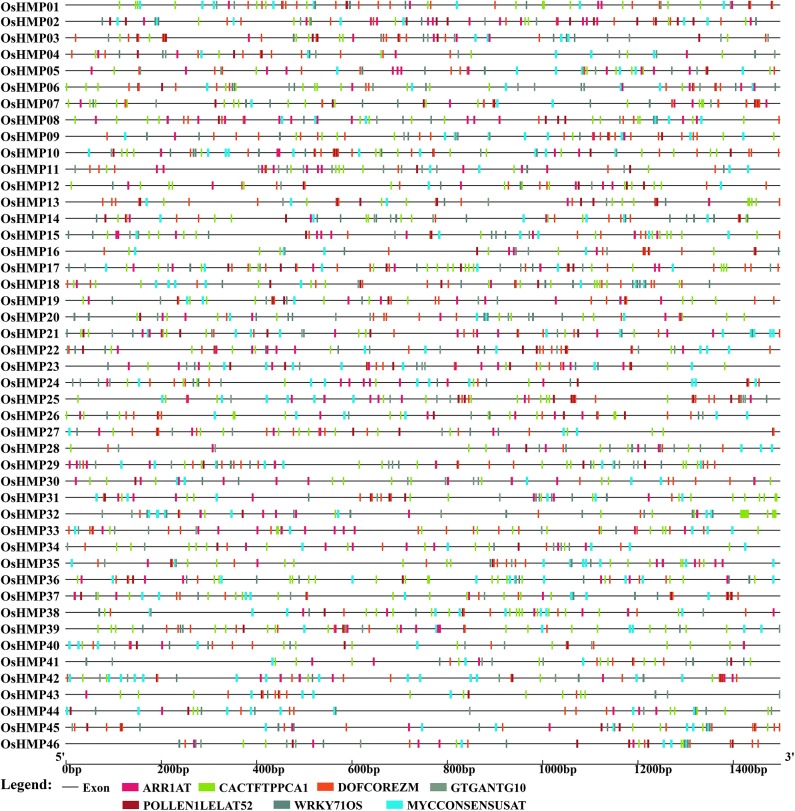
Predicted cis-elements in the promoter regions of the rice heavy-metal-associated genes. All promoter sequences (−1,500 bp upstream genomic sequence) were analyzed. The heavy-metal-associated genes are shown on the left side of the figure. The scale bar at the bottom indicates the length of promoter sequence. Different cis-elements were labeled by rectangle of different color.